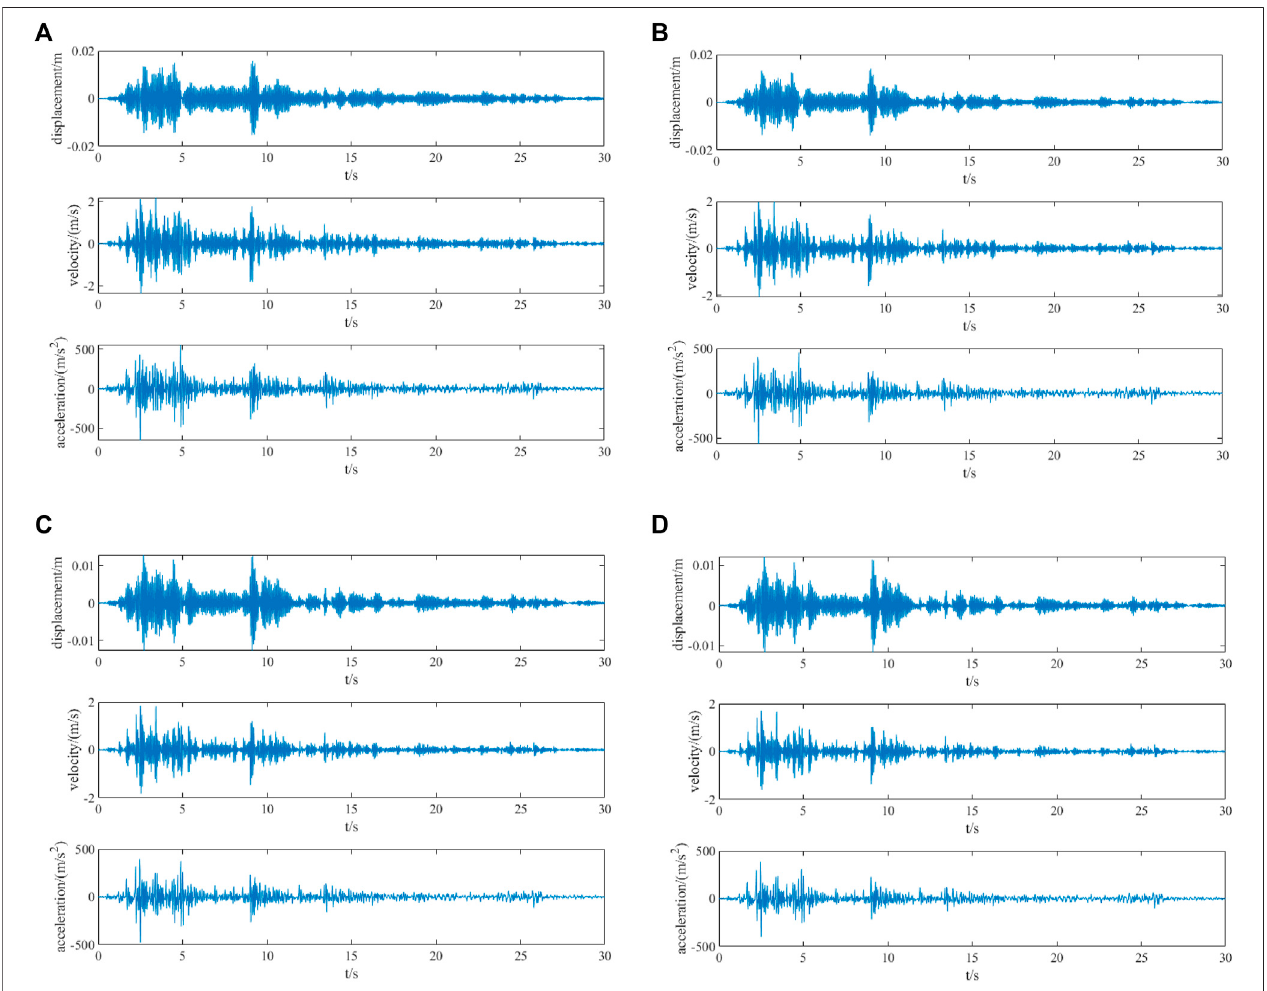
FIGURE10|(A) TimehistorycurveoftheoutputresponseunderElCentroseismicwaveexcitation( ζ =0.01). (B) TimehistorycurveoftheoutputresponseunderEl Centro seismic wave excitation ( ζ =0.015). (C) Timehistory curveofthe output response under El Centro seismic wave excitation ( ζ =0.02). (D) Time history curveofthe output response under El Centro seismic wave excitation ( ζ = 0.025)